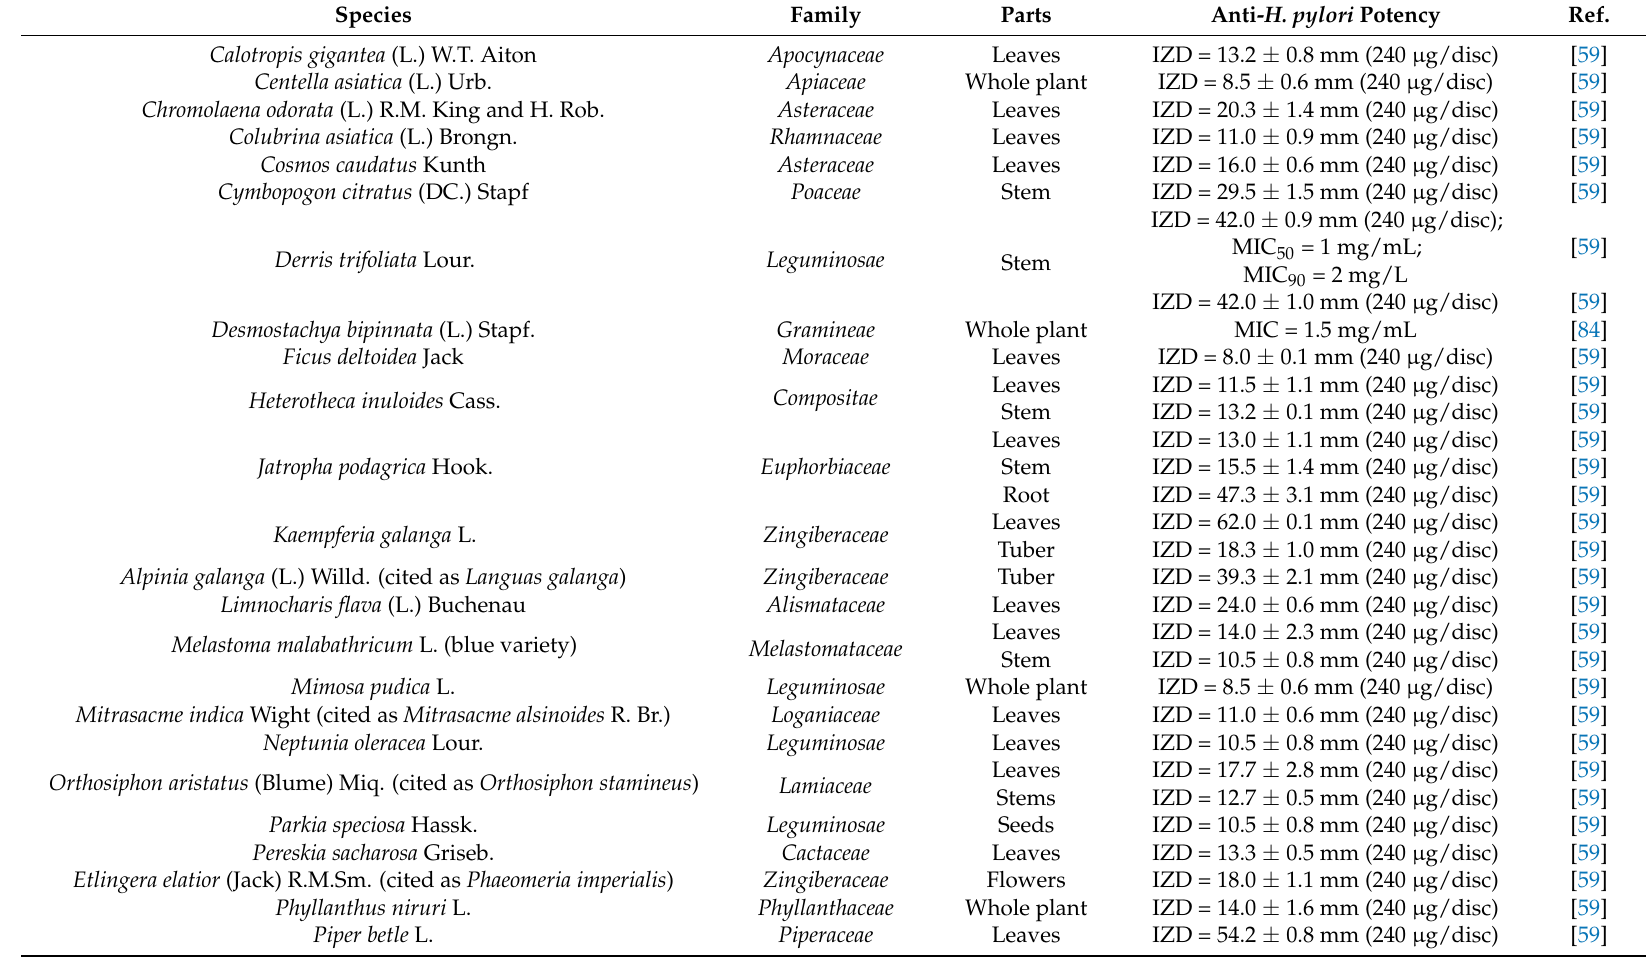
Table 7. Plant petroleum ether extracts with anti- H. pylori activity. Species Family Parts Anti- H. pylori Potency Ref. Calotropis gigantea (L.) W.T. Aiton Apocynaceae Centella asiatica (L.)